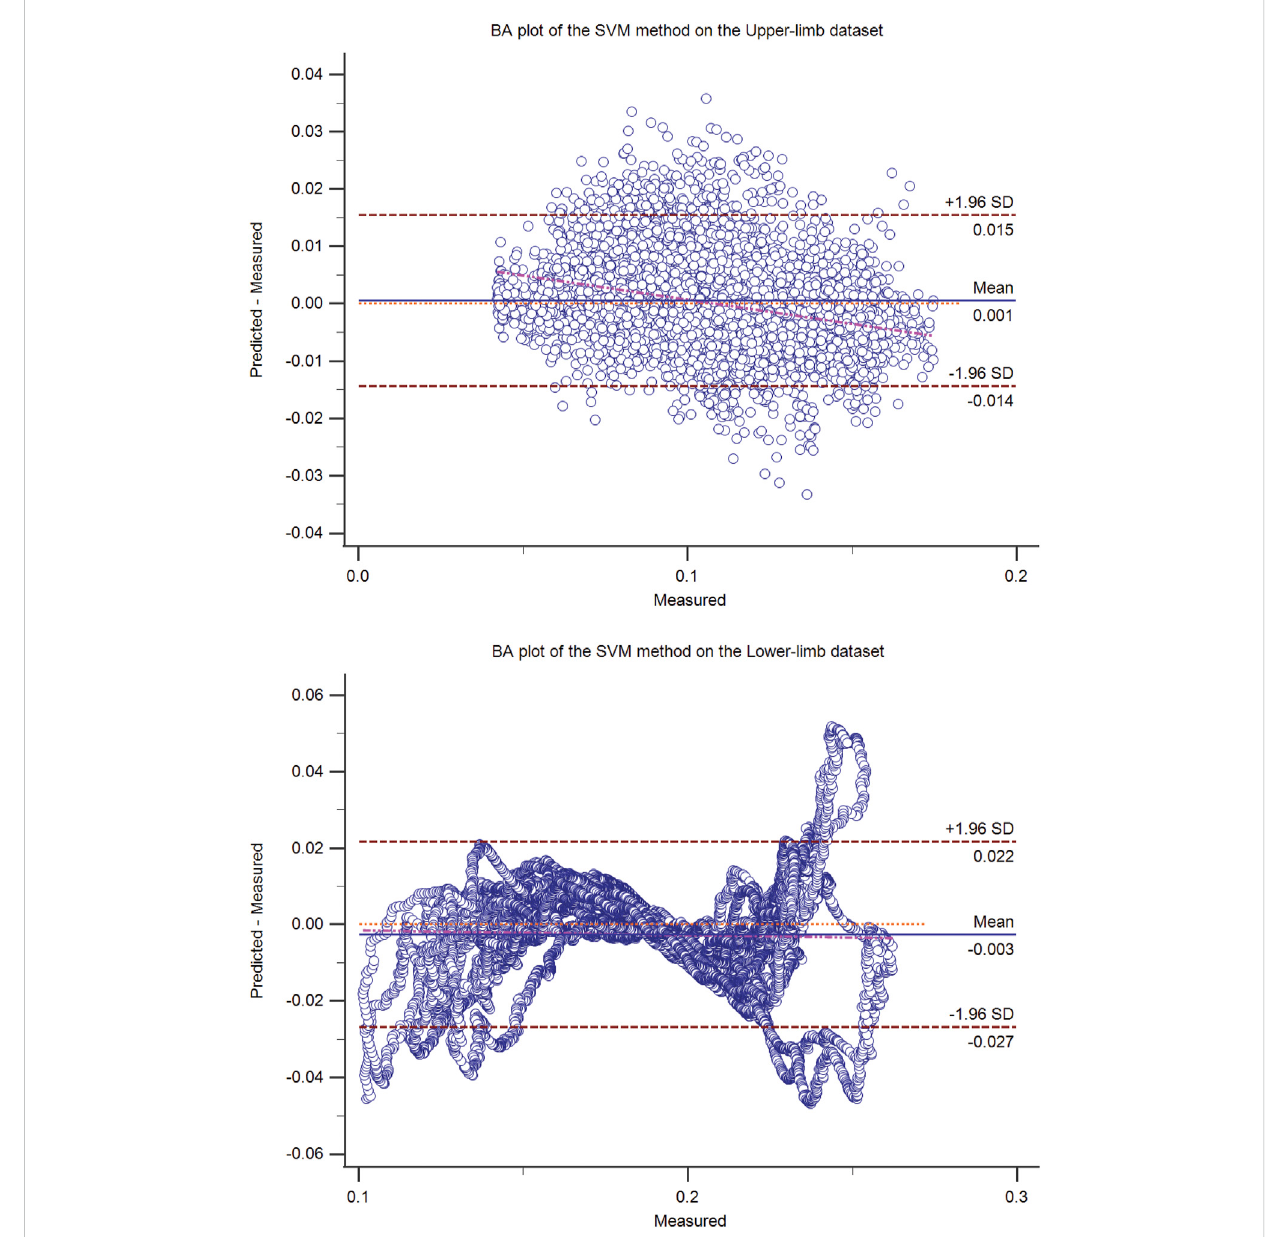
FIGURE 3 The Bland-Altman (BA) plot of the SVM method on the upper-limb (top) and the lower-limb (bottom) test dataset (50% hold-out validation). The BA plot shows the scatter plot of the residual signal (predicted force minus measured force signal) (y-axis) and the measured force signal (x-axis), which identi fi esthe homogeneity ofthe residual signal at different measured signal levels. In addition to themean residual signal (i.e., bias), the upper and lower boundaries (mean (residual signal) ± SD (residual signal)) are also